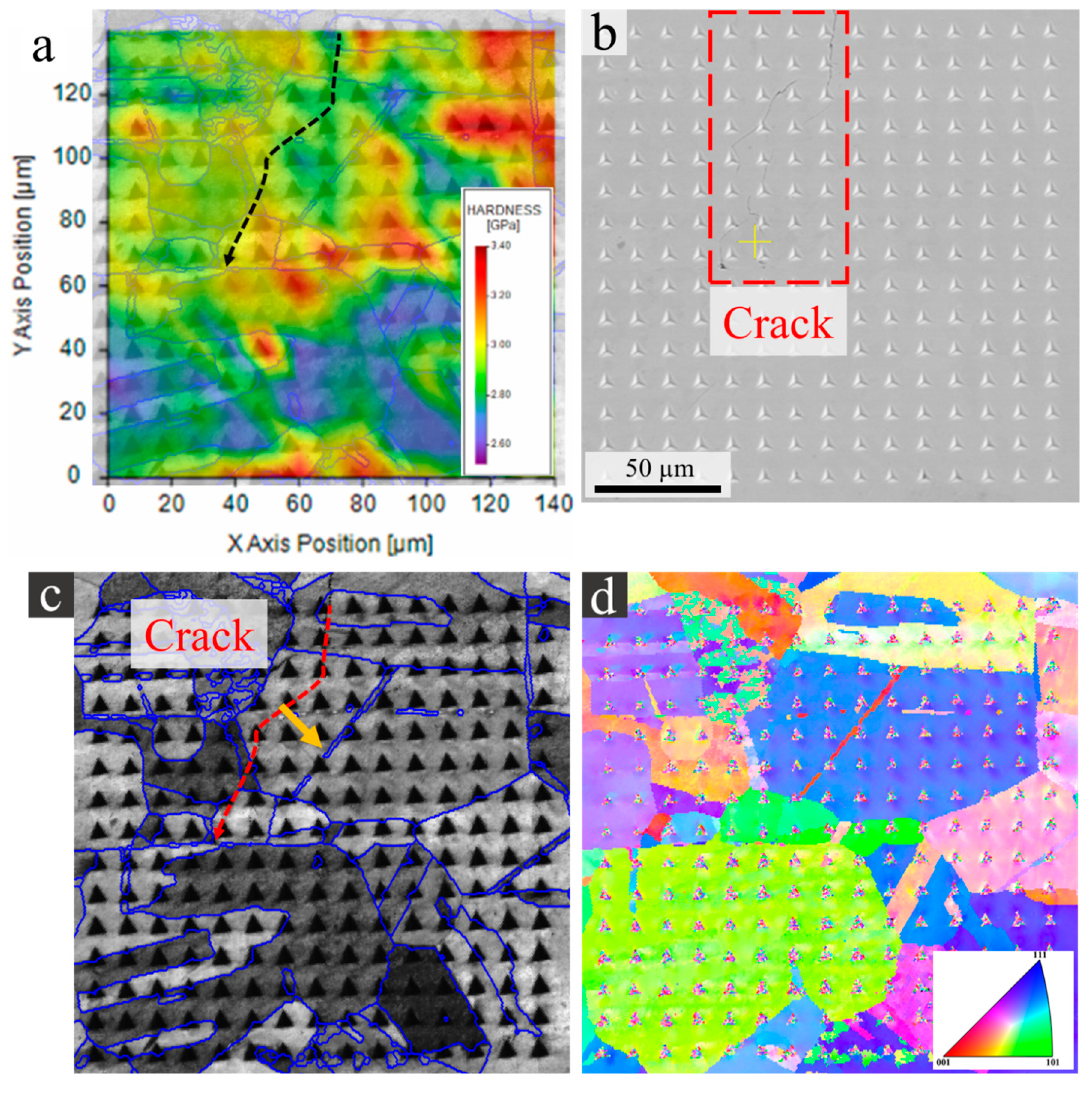
Figure 7. Crack #6 region: ( a ) NanoBlitz maps overlayed with EBSD-IQ map for identification of grain structure, with the crack path marked by the arrow; ( b ) SEM image of the mapped region with crack area marked in red rectangle; ( c , d ) EBSD-IQ and IPF maps, with GBs marked in blue, crack path traced with red dashed arrow corresponding to intergranular hardness profiles shown in Figure 8, and orange arrow indicating direction of intragranular hardness profiles shown in Figure 9.